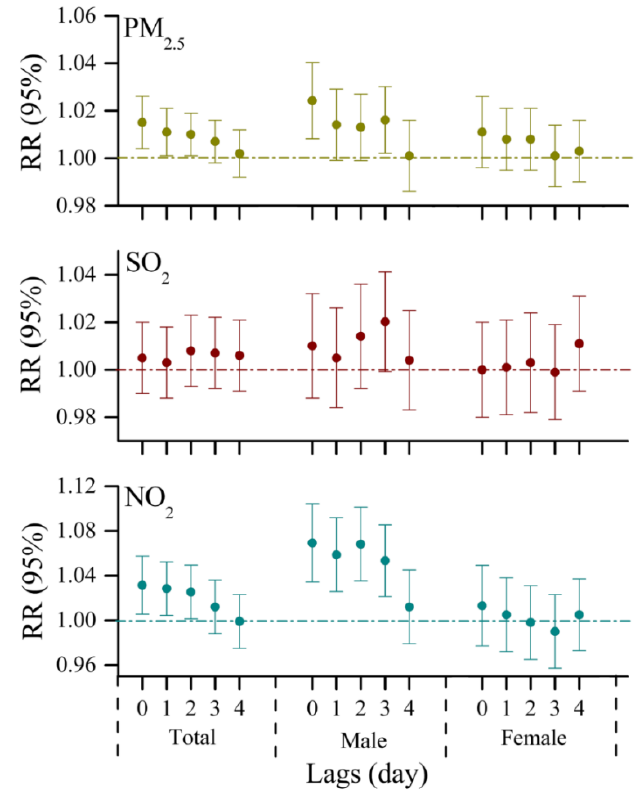
Figure 3. Relative risks (RRs with 95% CI) of hospital emergency room visits for respiratory complaints in association with per 10 µ g/m 3 increase in PM 2.5 , SO 2 and NO 2 for the suburban population of Jinan at different lags (lag0, lag1, lag2, lag3, lag4).